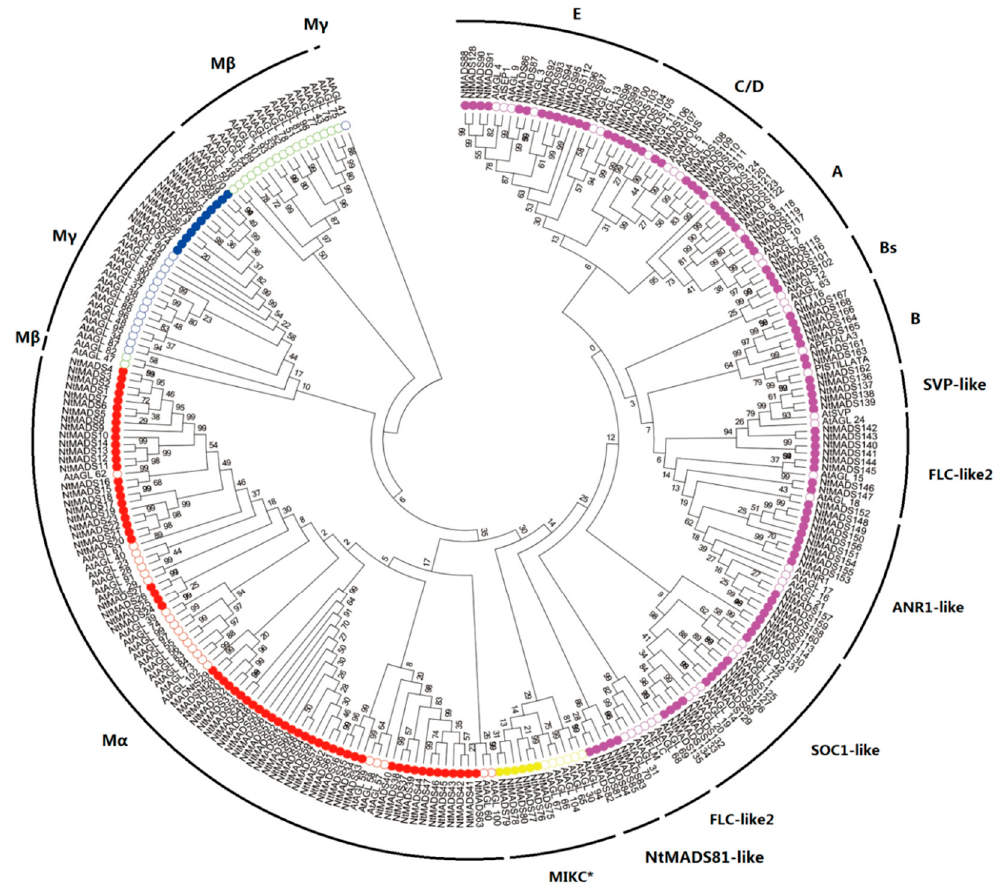
Figure 1. Phylogenetic analysis of NtMADS-box proteins from Arabidopsis and cultivated tobacco. A total of 107 AtMADS-box proteins from Arabidopsis ( Arabidopsis thaliana ) and 168 NtMADS-box proteins from cultivated tobacco were used to generate the unrooted neighbor-joining (NJ) tree with 1000 bootstrap replicates. The MADS-box proteins are classified into five subfamilies (marked as M α , M β , M γ , MIKC*, and MIKC C ), and distinguished by di ff erent colors: NtMADS-box proteins are labeled in a solid circle, and AtMADS-box proteins are labeled in a hollow circle.